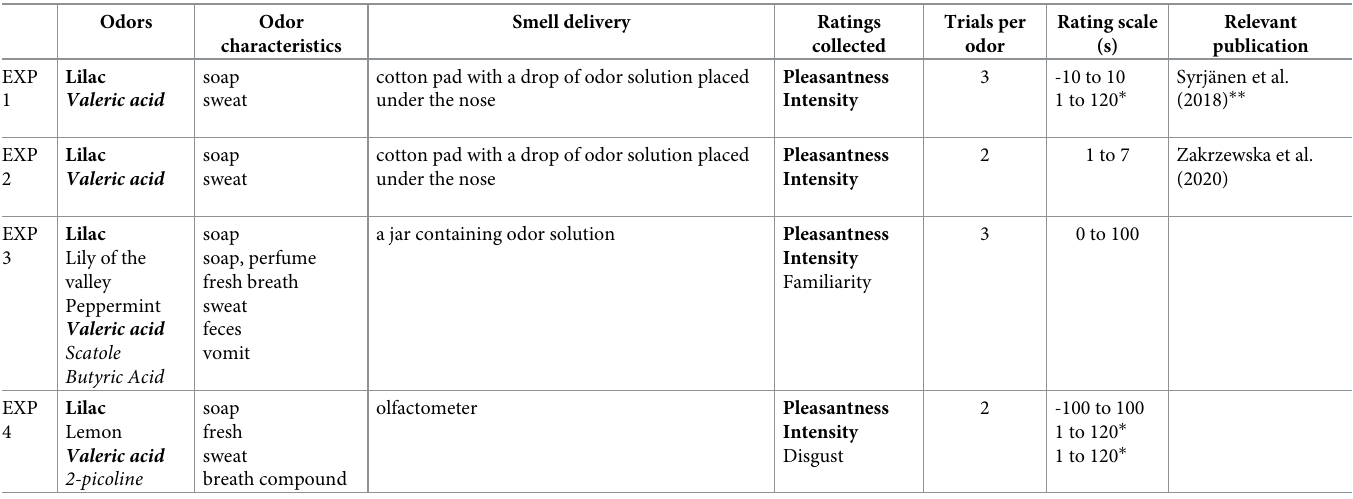
Table 2. Information about smell and ratings used in each